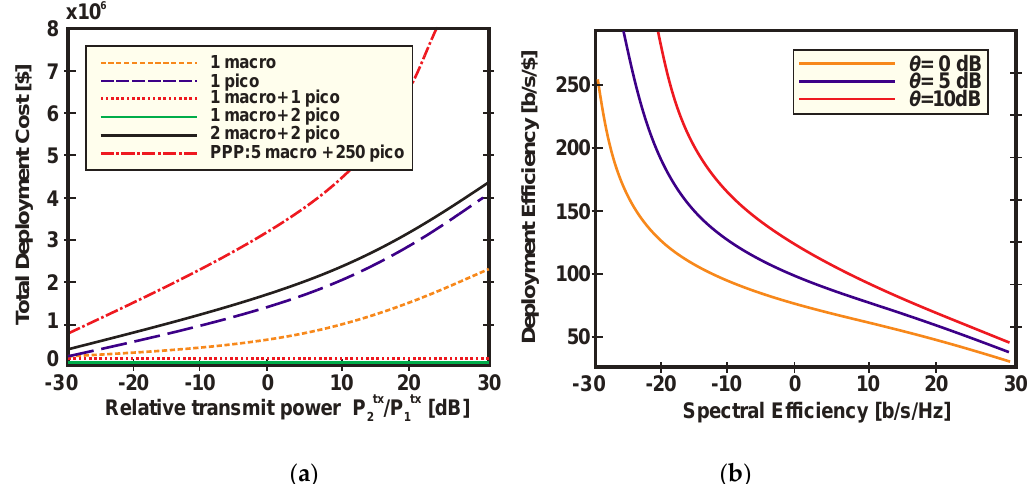
Figure 3. Total deployment costs and efficiency in the two-tier example: ( a ) deployment cost vs. transmit powers ratio: ( b ) deployment efficiency ( DE ) vs. SE .